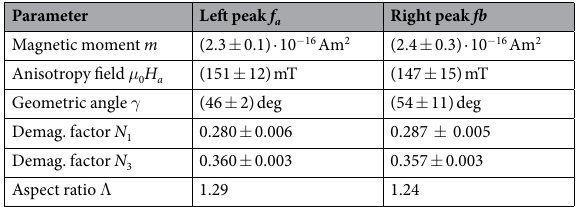
Table 2. Magnetic and geometric properties of the nanoparticles, obtained by fitting the frequency shift signal for both resonance peaks f a and f b and both field directions with equation (9). The fit values are averaged for fits of six consecutive measurements for each peak.